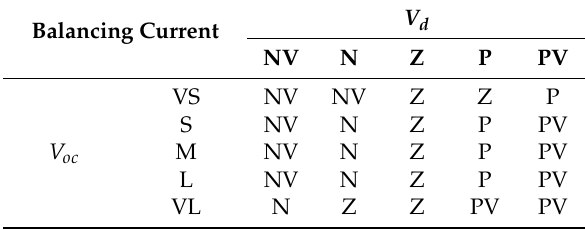
Table 1. Rule Base of an FL controller for Linguistic Variables.